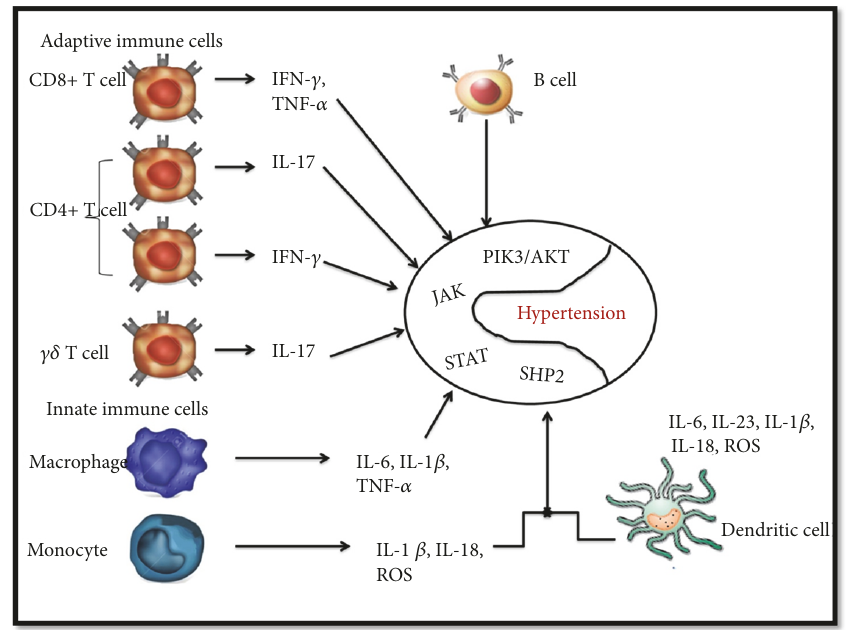
Figure 2: The inflammatory-mediated HTN process, immune cells via different signaling pathways. The known routes, like signal transducer and activator of transcription -1, -3, and -5 (STAT), janus-associated kinases (JAK), domain containing phosphatase (SHP2) or extracellular signal related kinase and phosphatidylinositol-3-kinase (PIK3/AKT), depend on the specific interleukin production.